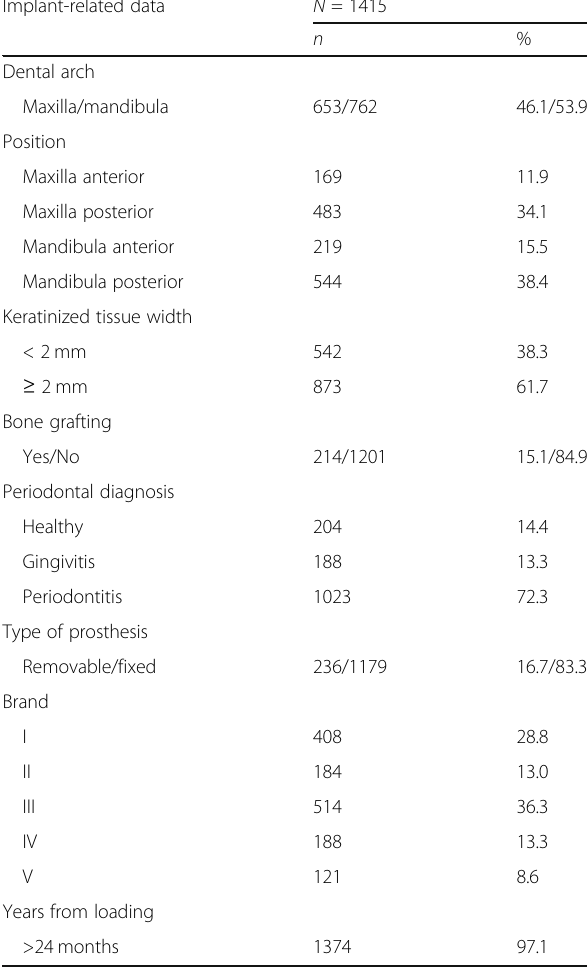
Table 2 Implant-related data analyzed in this study Implant-related